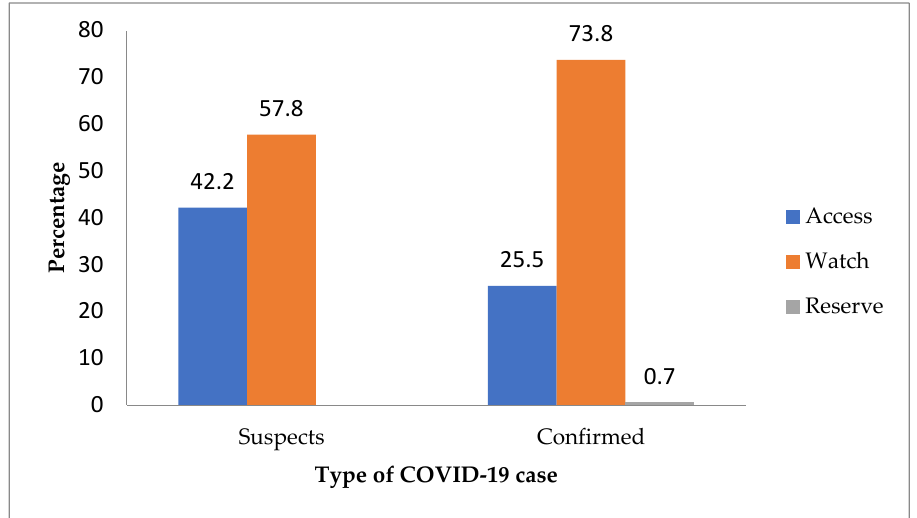
Figure 1. Prescription of antibiotics according to the WHO AWaRe classification of antibiotic use in suspected and confirmed COVID-19 patients admitted to isolation units and treatment centres in